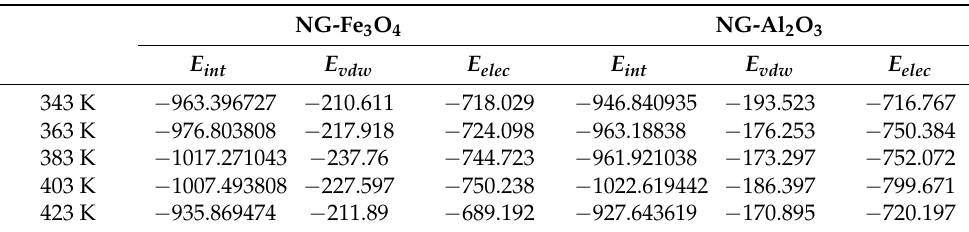
Table 3. Interaction energy between metal oxide and insulating oil molecules under the action of the electric field (kcal/mol).